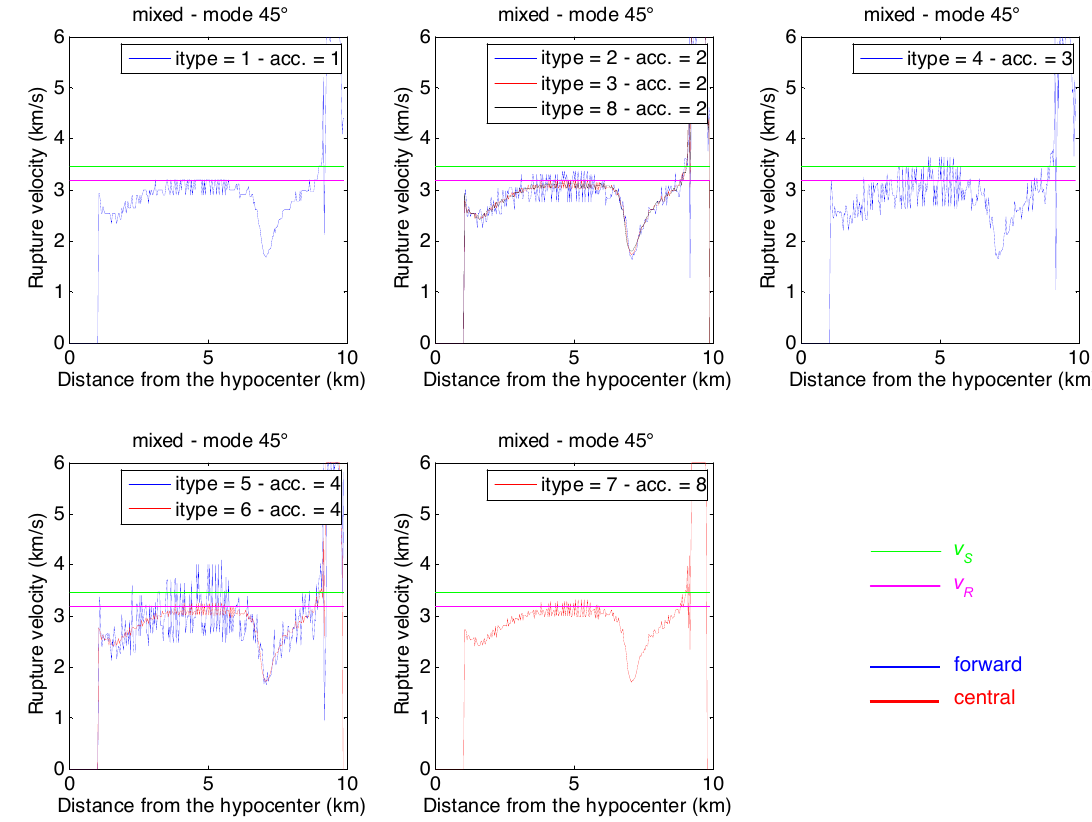
Figure 4. The same as in Figure 2, but now for a mixed–mode profile, having an azimuth angle of 45° with respect to the x